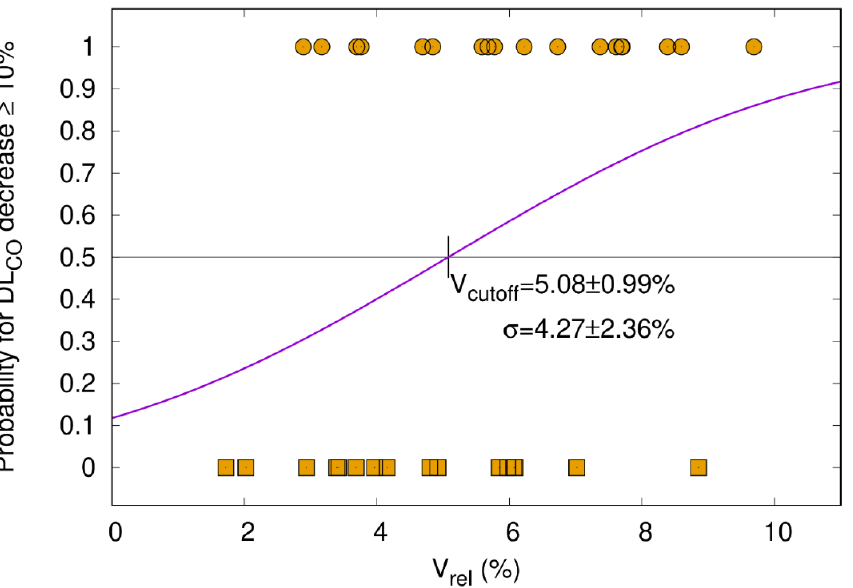
Figure 4. Patients without ICI (=immune checkpoint inhibitor). The probability of DL CO decrease ≥ 10% after the end of RT (y-axis) is plotted as a function of the relative size of V 65–45% with respect to